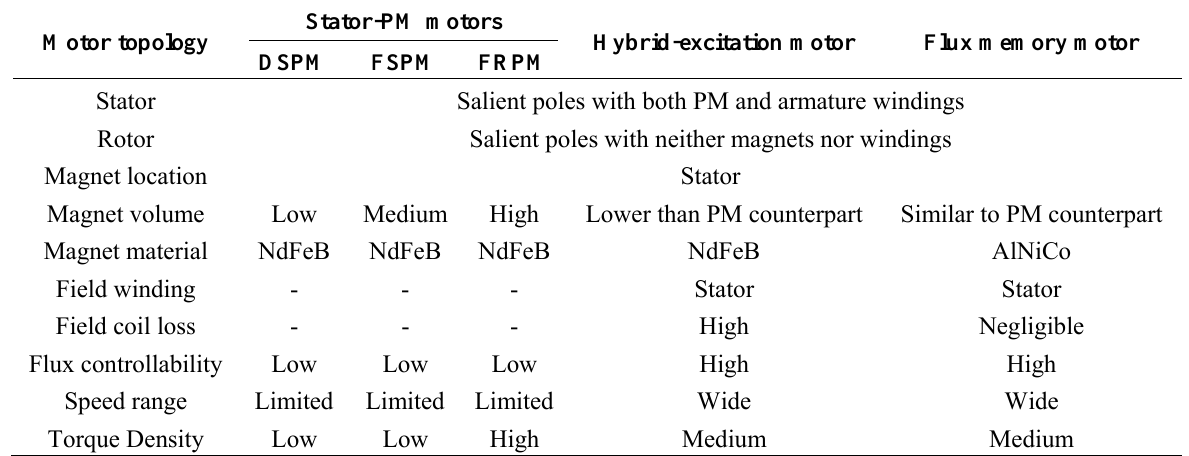
Table 3. Comparison of different motor